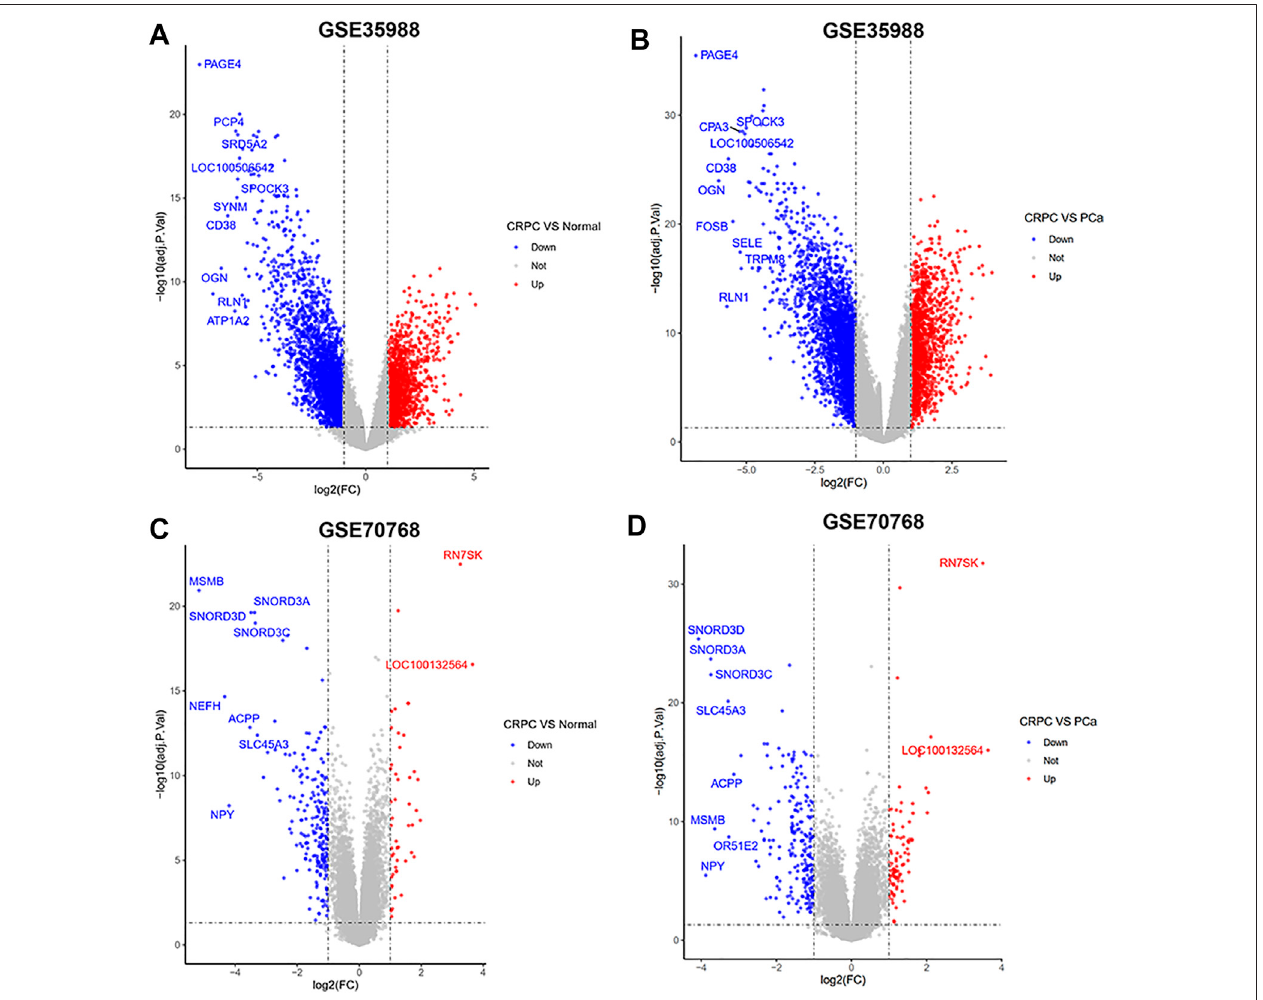
FIGURE 2 | Volcano plots of DEGs compared CRPC with normal and PCa samples. (A,C) DEGs of CRPC compared with normal samples in GSE35988 and GSE70768. (B,D) DEGs of CRPC compared with PCa samples in GSE35988 and